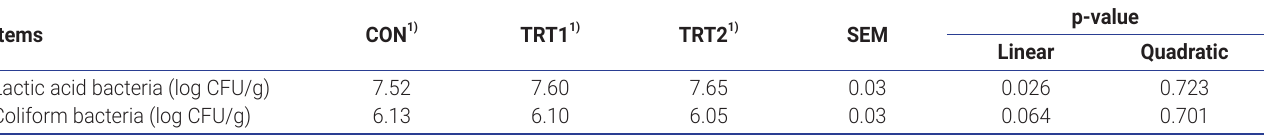
Table 4. Effect of dietary supplementation Achyranthes japonica extracts on fecal microbial shedding in growing pigs